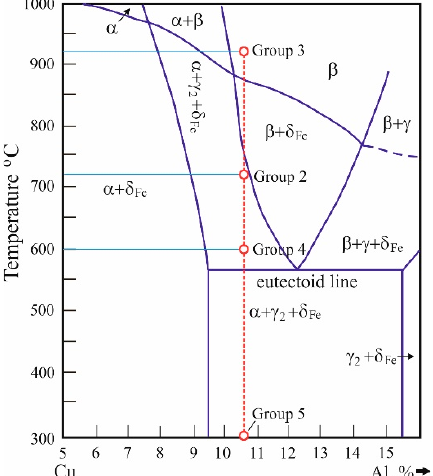
Figure 4. A section of the Cu-Al-Fe equilibrium phase diagram with a 5% Fe plane [1].